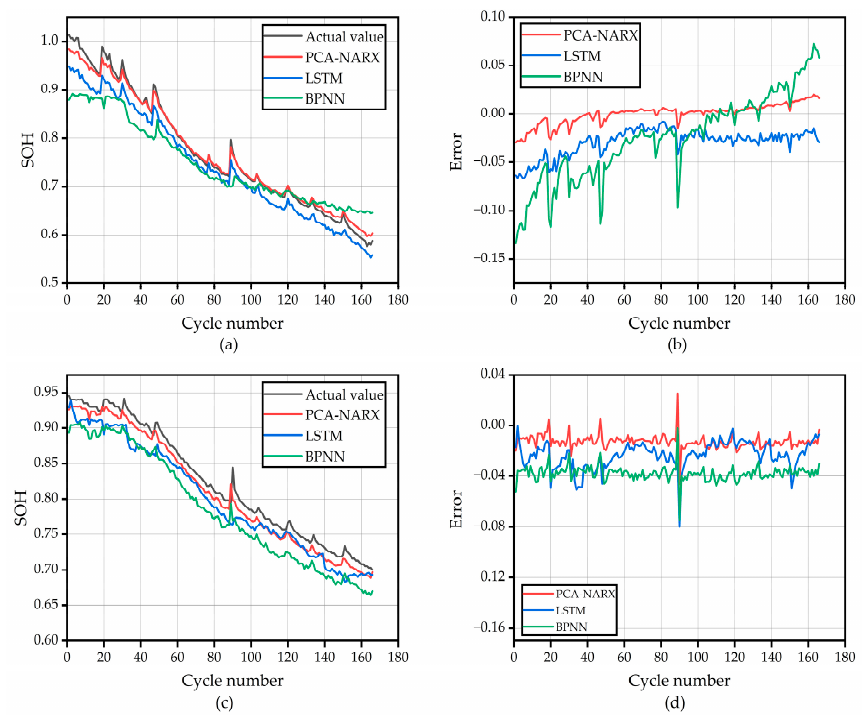
Figure 7. ( a ) Comparison of SOH estimation curves of B0006 battery; ( b ) Errors of SOH estimation of B0006 battery; ( c ) Comparison of SOH estimation curves of B0007 battery; ( d ) Errors of SOH estimation of B0007 battery.